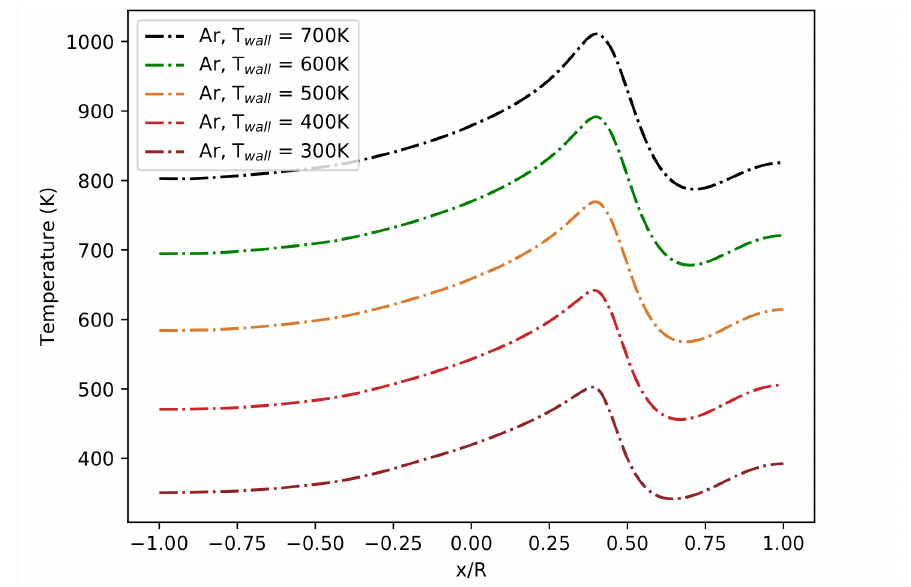
Figure 9. Heat flux distribution for Mach 10 argon flow when wall and porous domain temperature is varied.